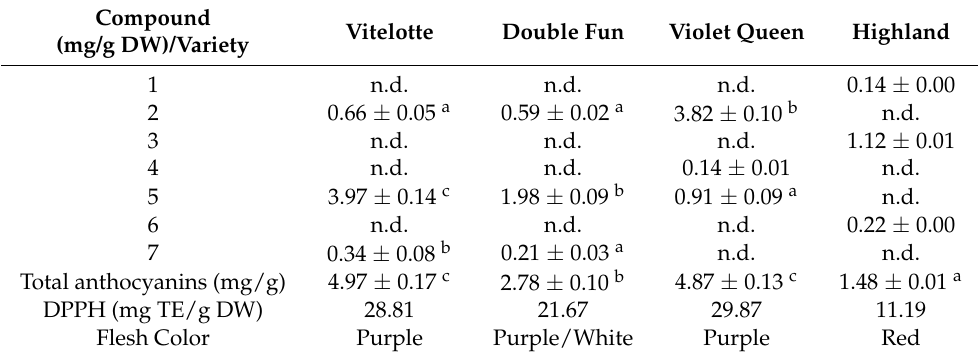
Table 4. Concentration of anthocyanins (mg g − 1 DW) and antioxidant activity (DPPH, mg TE g − 1 DW) of purple and red flesh potatoes. Different letters on the same line mean that the values are significantly different. Compound (mg/g